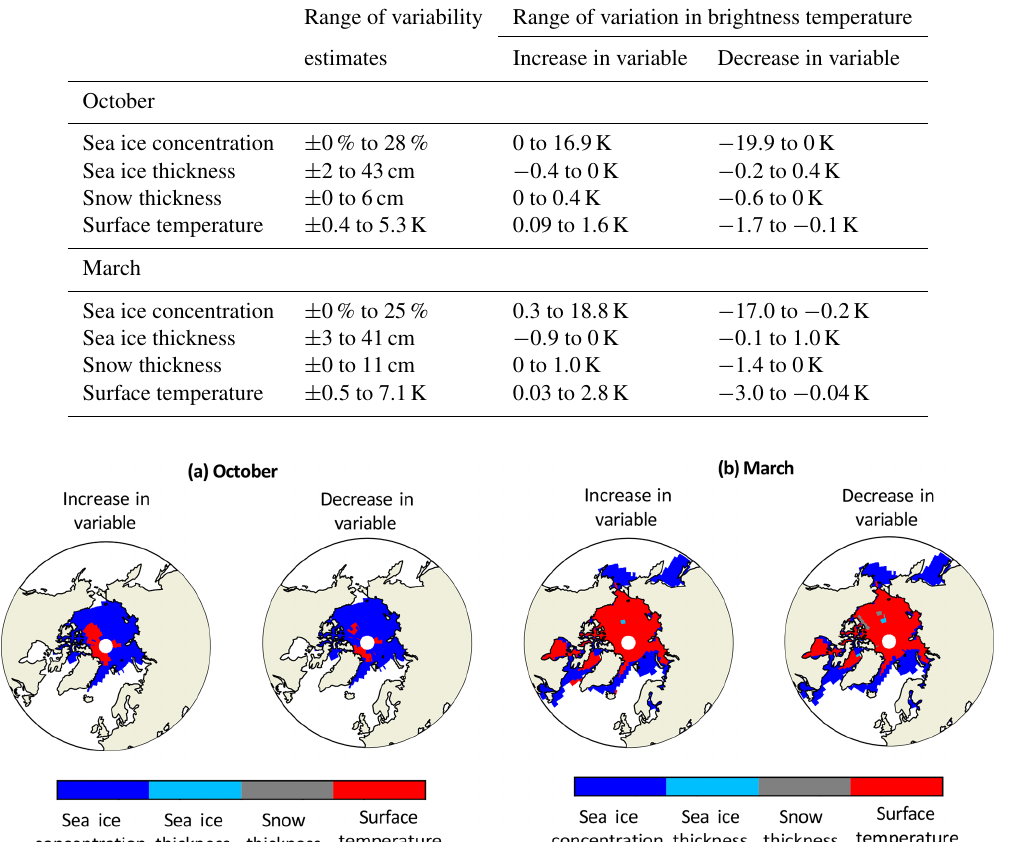
Table 1. Sensitivity of the simulated brightness temperature to different input variables of the simulation. We show the spatial 5th and 95th percentile of the time mean of the estimated variability for the variables of interest (also see Fig. B1) in the first column. We show the spatial 5th and 95th percentile of the time mean difference between modulated and reference brightness temperature when the variability field is added to (second column) and subtracted from (third column) the reference field. These values are inferred from the SICCI2 assimilation run.